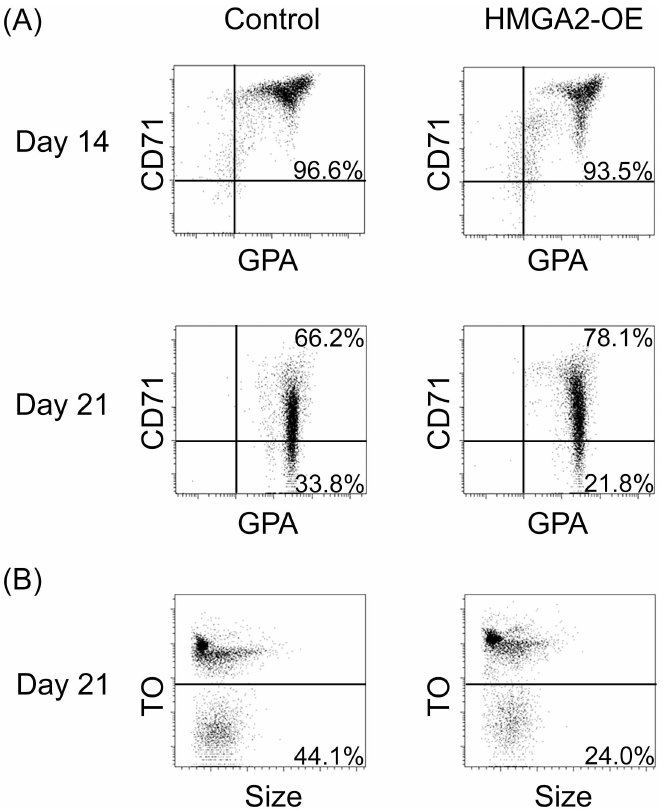
Fig 2. Erythroid-expression of HMGA2 leads to slightly lower levels of terminal maturation and enucleation compared to control transductions during in vitro erythroblast differentiation. Representative donor flow cytometry analysesof (A) empty vector control and HMGA2-OE at culture days 14 and 21 stainedwith anti-transferrin receptor (CD71) and anti-glycophorinA (GPA) antibodies. (B) Enucleation of empty vector control and HMGA2-OE transductions assessedby stainingof culture day 21 cells with thiazoleorange. Percentagesshown in the figure correspond to one representative donor, averagevalues are shown in the text. C = empty vector control transduction; HMGA2-OE = HMGA2